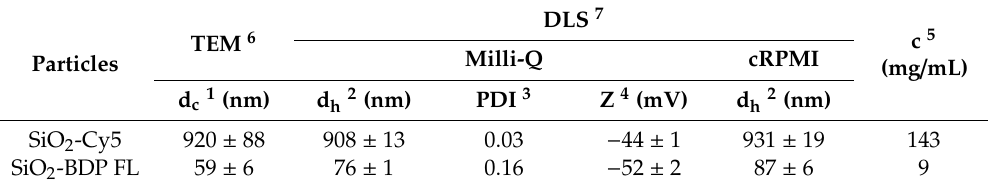
1 core diameter, 2 hydrodynamic diameter measured after particle incubation at 37 ◦ C for 24 h, 3 polydispersity Table 1. Representation of the main physicochemical characteristics of silica (SiO 2 ) particles. index, 4 zeta potential, 5 concentration, 6 transmission electron microscopy, 7 dynamic light scattering, SiO 2 -Cy5: silica Cyanine 5, SiO 2 -BDP FL: silica BODIPY ® -fluorescein, and cRPMI: Roswell Park Memorial Institute complete cell culture medium.